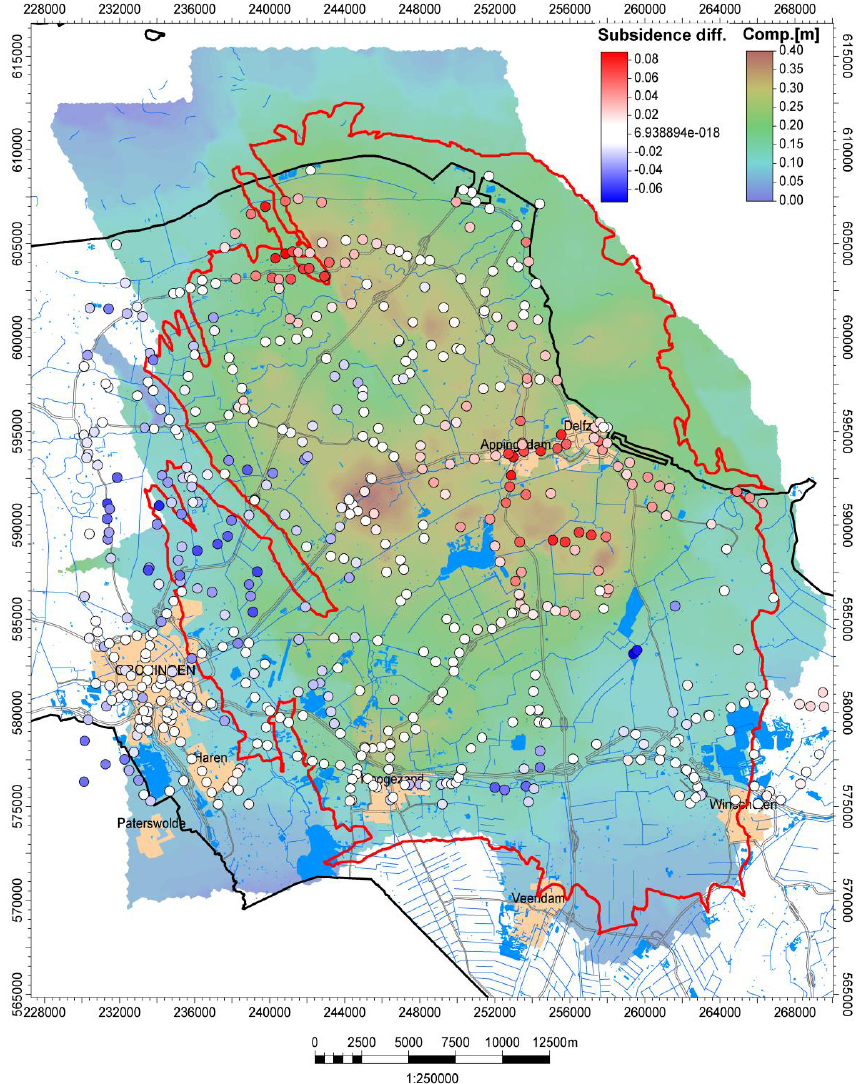
Figure 4. Compaction in the Groningen reservoir at January 2012 calculated with the RTiCM model (from TNO, 2014). The difference between calculated and modeled subsidence is indicated at the benchmark locations (label: Subsidence diff). A red color indicates that the measured subsidence is larger than the modeled